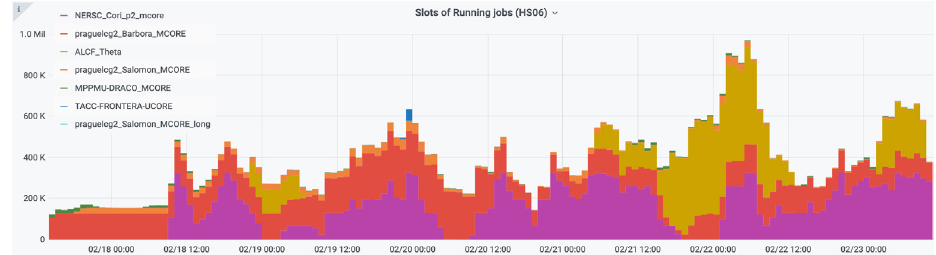
Figure 3. The number of running job slots at HPC sites versus time (between February 17-23,